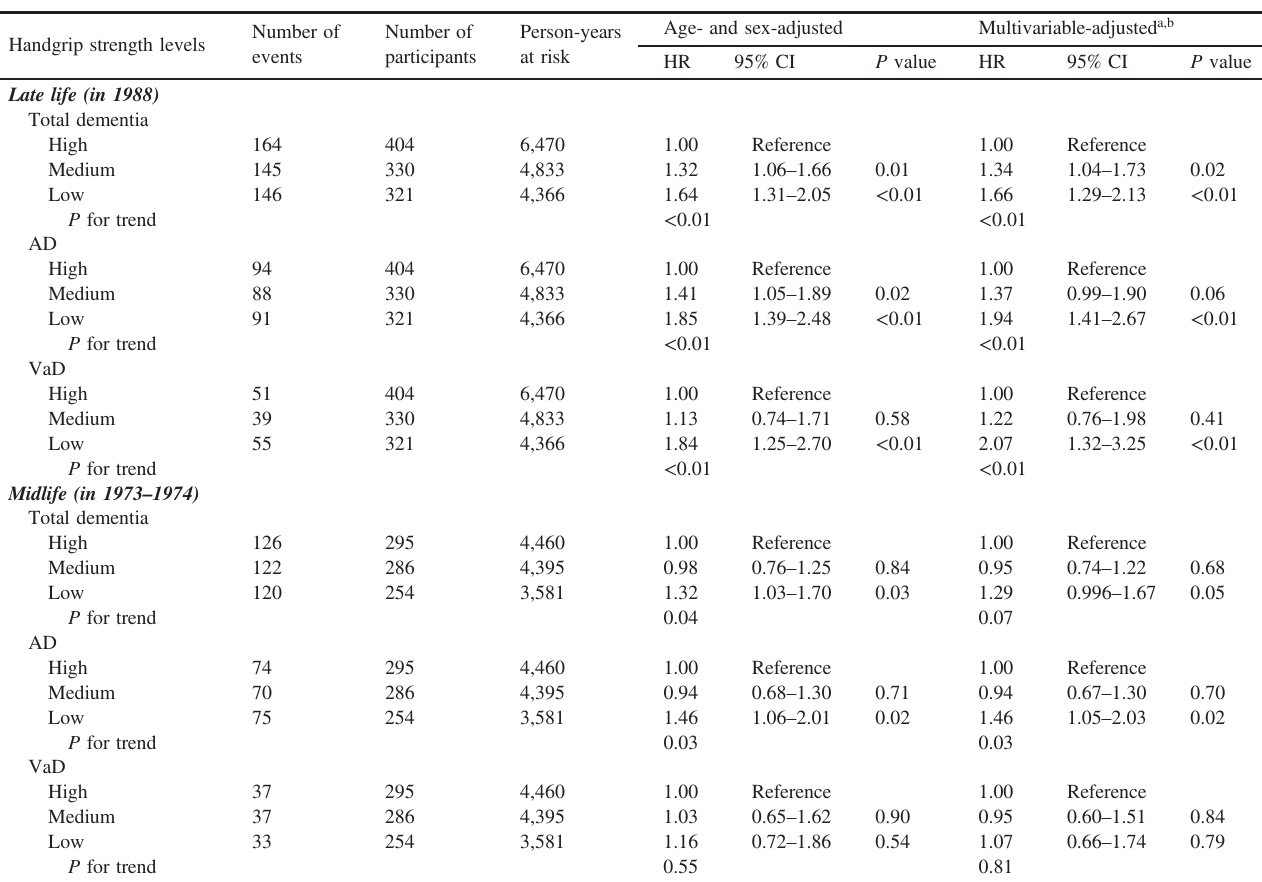
Table 3. Hazard ratios for the development of total dementia and its subtypes according to handgrip strength levels in late life or midlife Handgrip strength